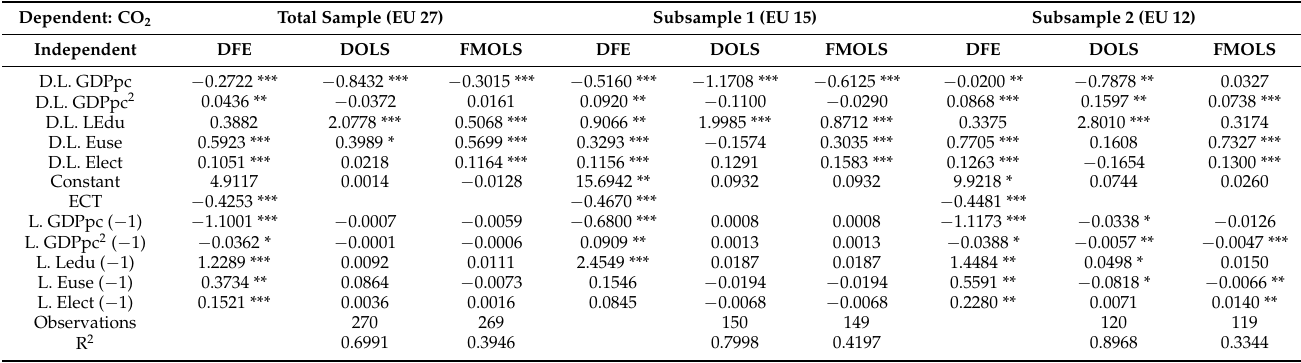
Table 6. DFE, DOLS, and FMOLS results for the total sample (EU-27), subsample 1 (EU-15), subsample 2 (EU-12) regarding Equation (2).